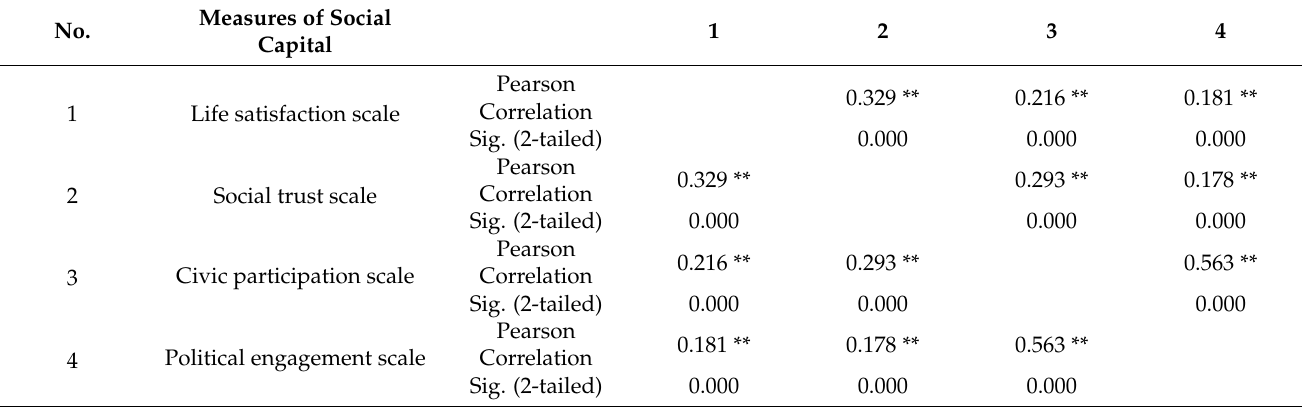
Table 2. Pearson correlations between the measures of social capital and Social Networking Sites and Apps (SNSAs) use.